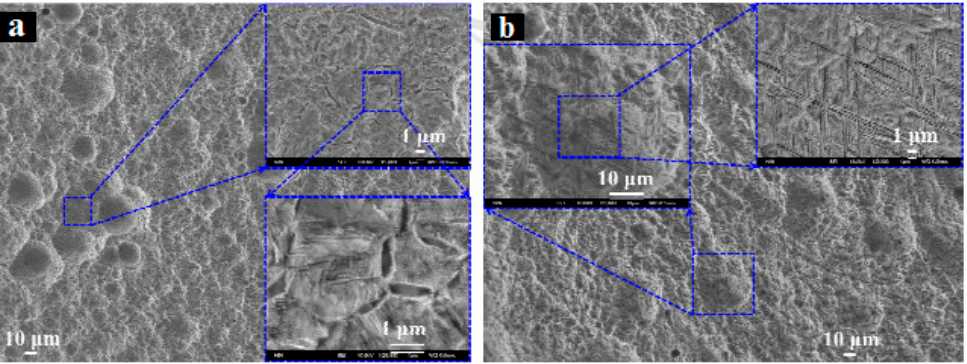
Figure 4. SEM morphologies of Ti-1300 (Ti-5Al-3Zr-4Mo-4Cr-4V) surface in 5 M HCl solution: ( a ) lamellar, and ( b ) equiaxed microstructure [45].